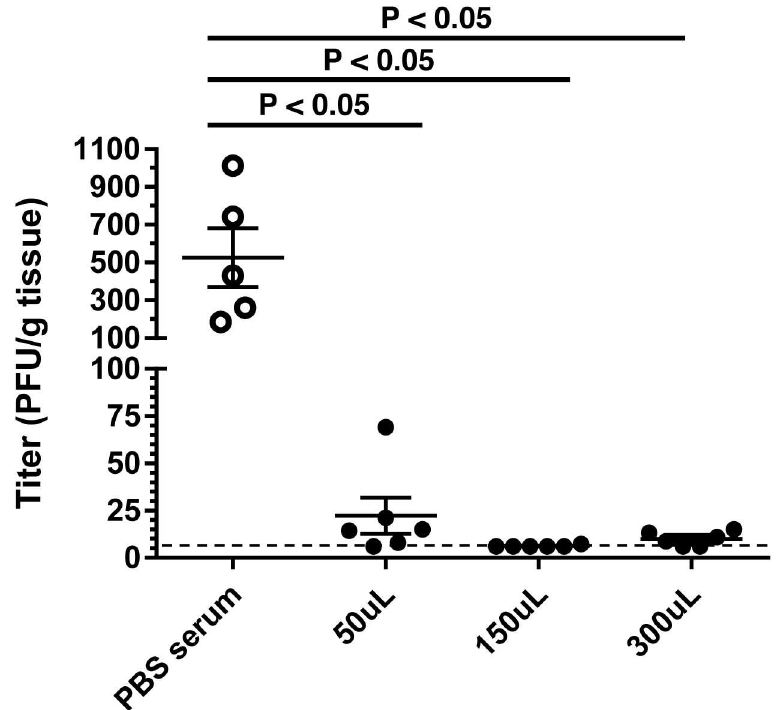
Fig 3. Reduced lung viral titers of challenged IFN- α / β R − / − mice that receivedpassive transfer of serum from MuV-IA-immunized mice. BALB/c mice were immunizedi.n. with 1x10 6 PFU of MuV in a volume of 100 μ L or mock immunized with 100 μ L PBS. Mice were boostedat 3 and 6 wpi, and serum was collectedand pooledat 8 wpi. Na ï veIFN- α / β R − / − mice receivedpassive transfer of 300 μ L i.p. of inactivedserum from MuV-IA immunizedmice (50 μ L and 150 μ L groups receivedserum diluted in PBS for 300 μ L total volume), or 300 μ L i.p. inactivatedserum from PBS immunizedmice. Mice were challenged 24 hours post passive transfer i.n. with 1x10 6 PFU of MuV-IA in a volume of 100 μ L. Lungs were collectedand homogenized 2 dpi and viral titers were determined by plaqueassay in duplicate. The limit of detectionof 5.9 PFU/g tissue is represented by the dashedline. ANOVA and Tukey multiplecomparisontests were used to calculate P values.